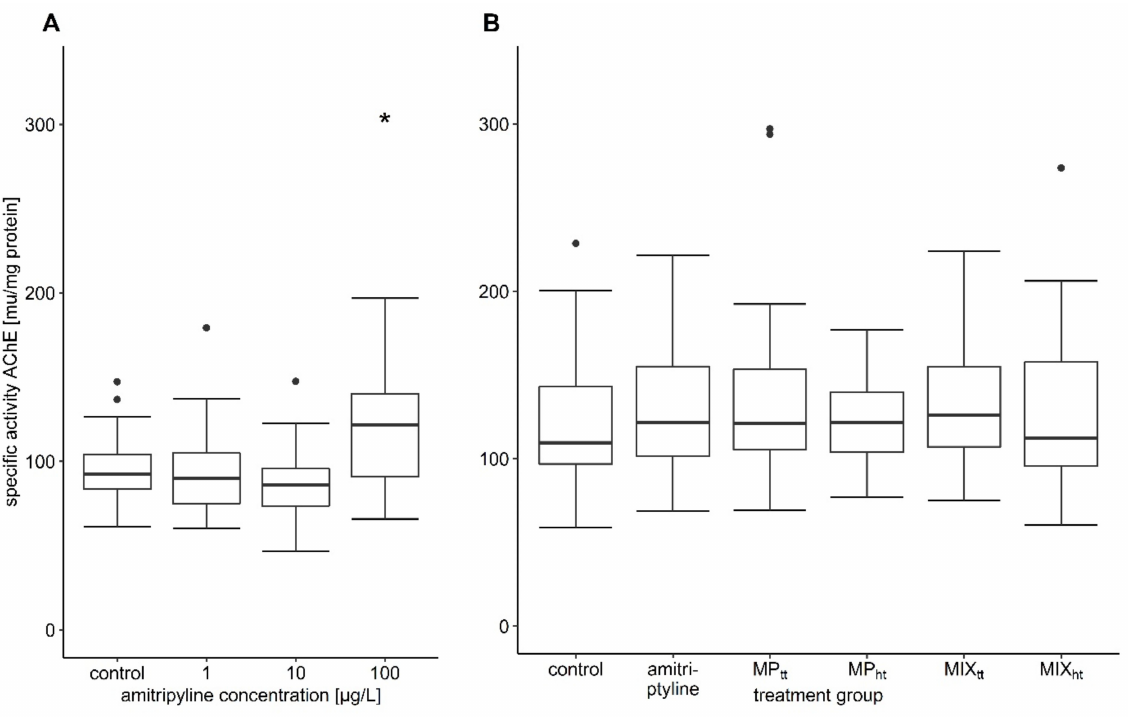
Figure 4. Specific activity of AChE. ( A ) first experiment: control n = 25, 1 µ g/L and 100 µ g/L amitriptyline n = 24, 10 µ g/L amitriptyline n = 26; ( B ) second experiment: all treatment groups n =